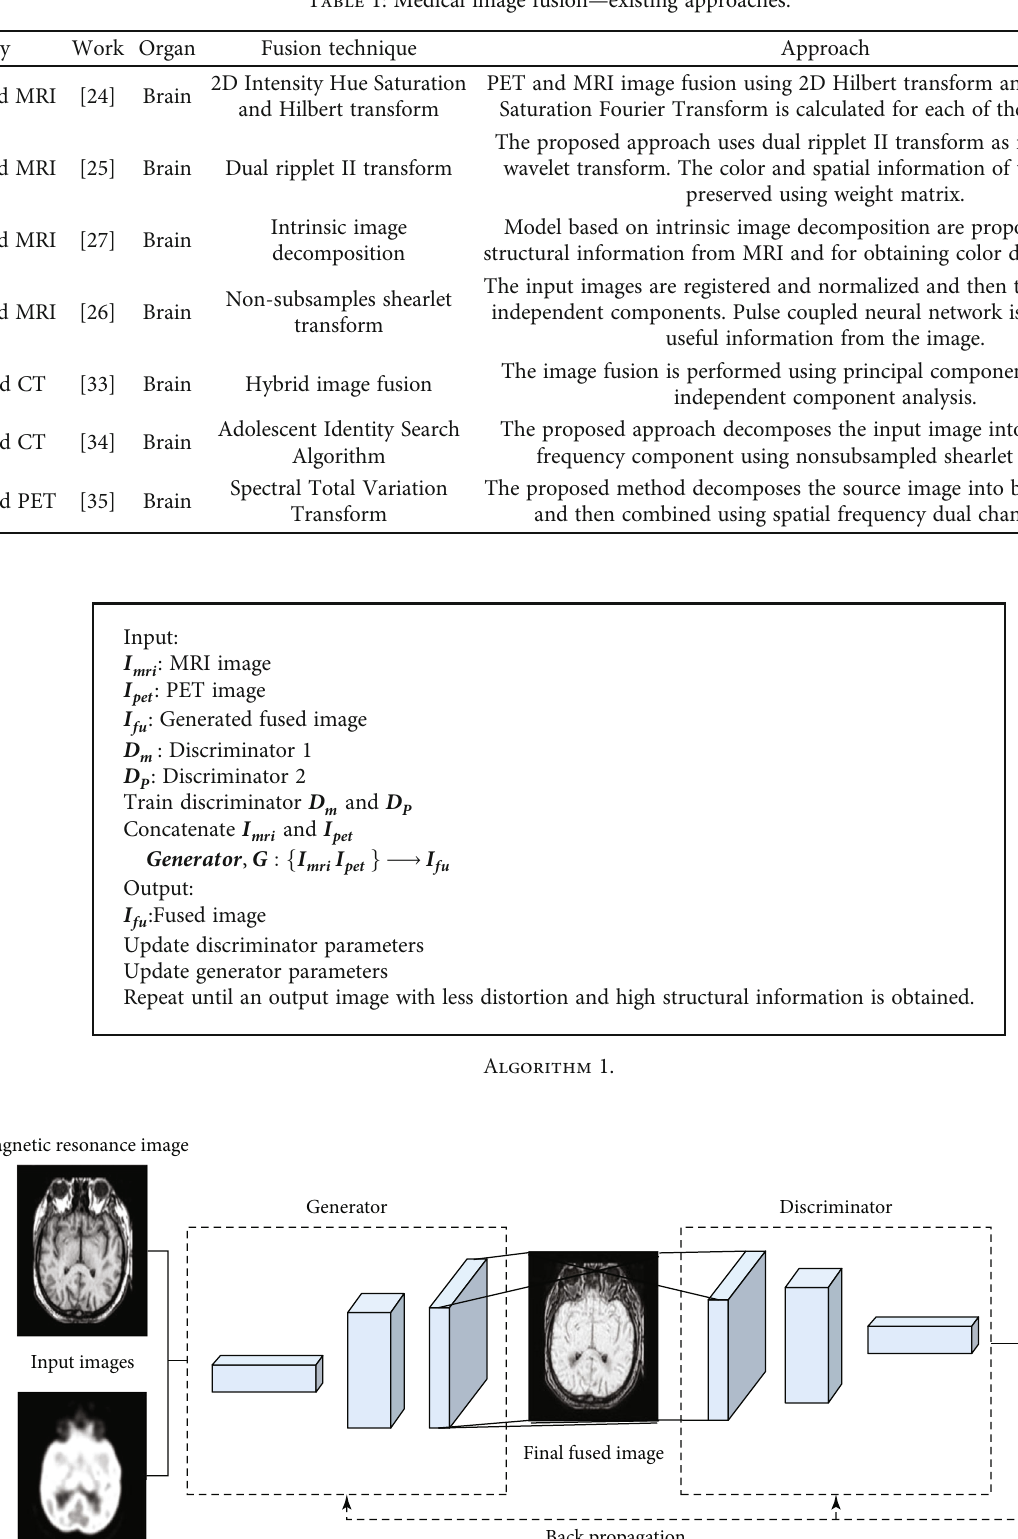
Table 1: Medical image fusion — existing approaches.